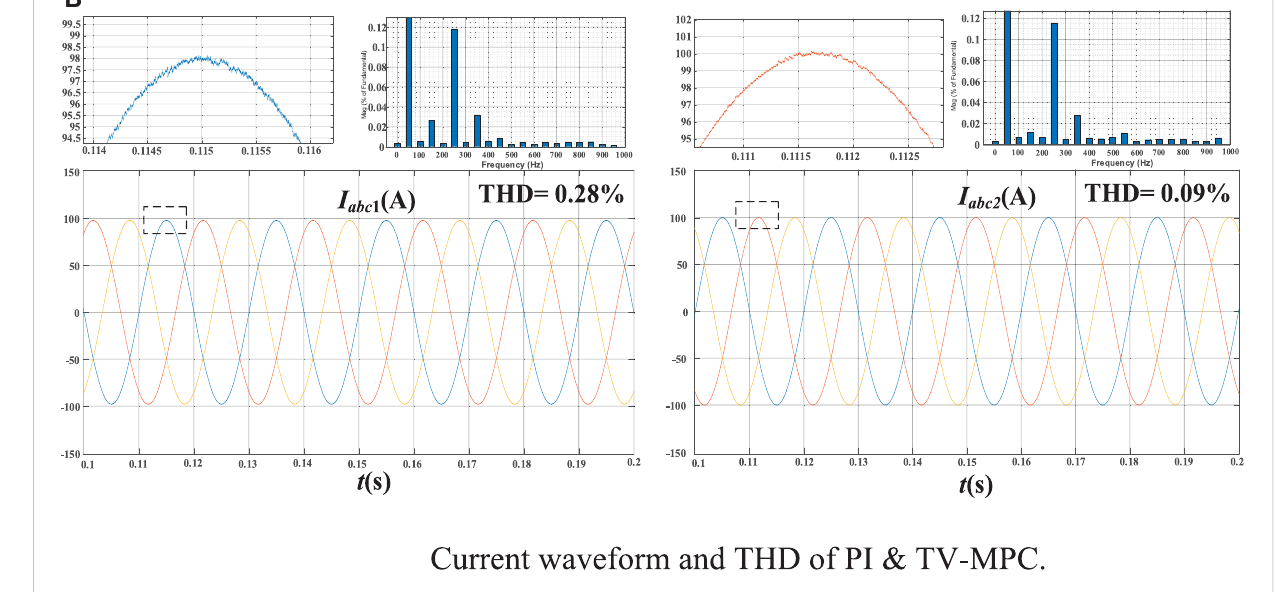
FIGURE 8 (A) Current waveform and THD of PI & MPC. (B) Current waveform and THD of PI &